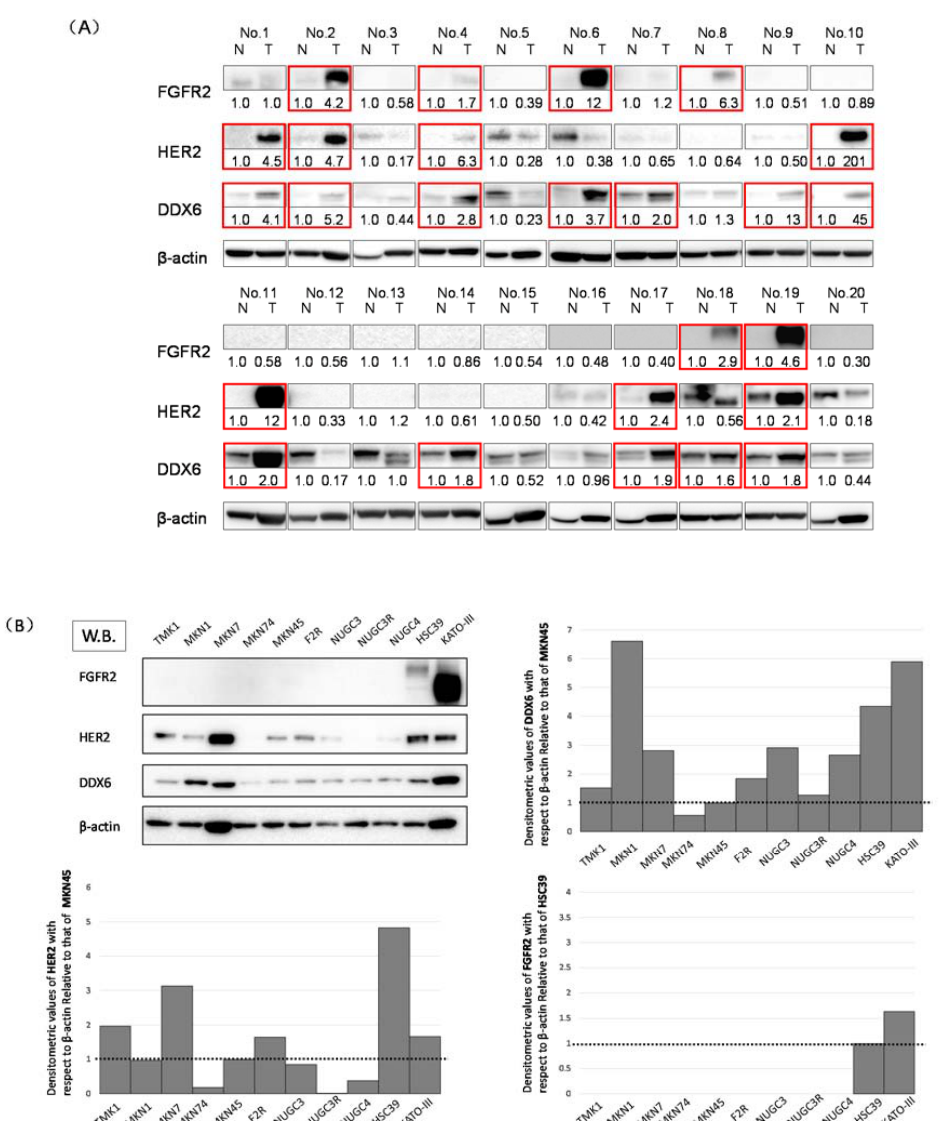
Figure 1. The expression levels of DDX6, HER2, and FGFR2 in gastric cancer (GC) cell lines and GC clinical samples. ( A ) Western blots of the 20 clinical samples. The overexpression of DDX6, HER2, and FGFR2 in tumor samples is highlighted by red ‐ boxes. N: normal, T: tumor in the same patient. Details of the characteristics of the patients are given in Table 1. Densitometric values of DDX6, HER2, and FGFR2 with respect to β‐ actin of each sample were calculated and the values are shown with each normal sample taken as 1.0. Densitometric values more than 1.5 are regarded as overexpressed. The cases that overexpressed DDX6, HER2, and FGFR2 are highlighted by red boxes; ( B ) Western blotting (W.B.) of the steady ‐ state levels of DDX6, HER2, and FGFR2 in GC cell lines. Cell lines including TMK1, MKN1, MKN7, MKN74, MKN45, F2R (MKN45 ‐ 5FU resistant [5FUR]), NUGC3, NUGC3 ‐ 5FUR, NUGC4, HSC39, and KATO ‐ III. In the expression levels of HER2 and DDX6, densitometric values of DDX6 with respect to β‐ actin of each sample were calculated and the values are shown with MKN45 taken as 1.0. In the case of FGFR2, the values are shown with HSC39 taken as 1.0.